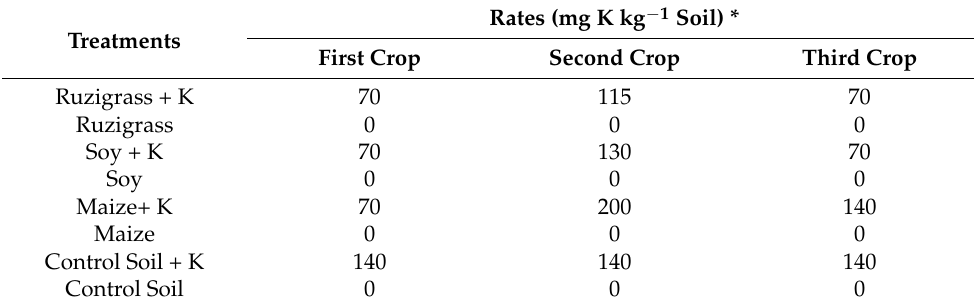
Table 2. Potassium (K) application rates for three crop cycles.